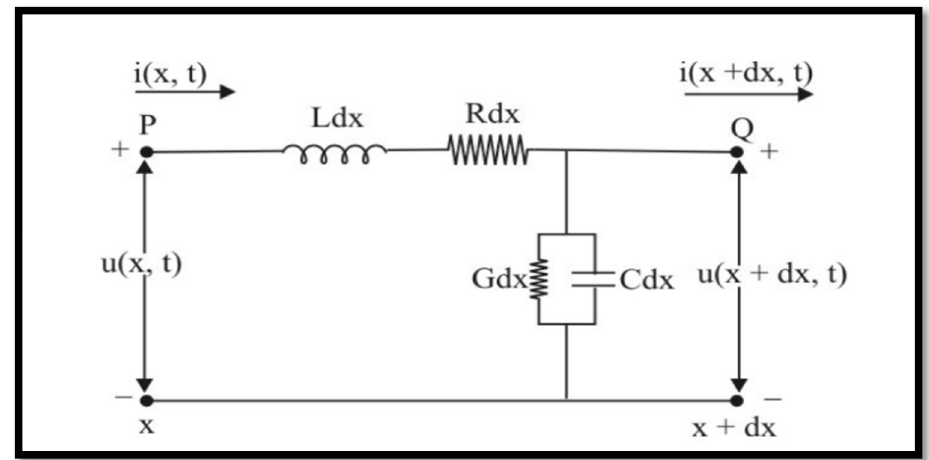
Figure 9. Telegraph transmission line with leakage.